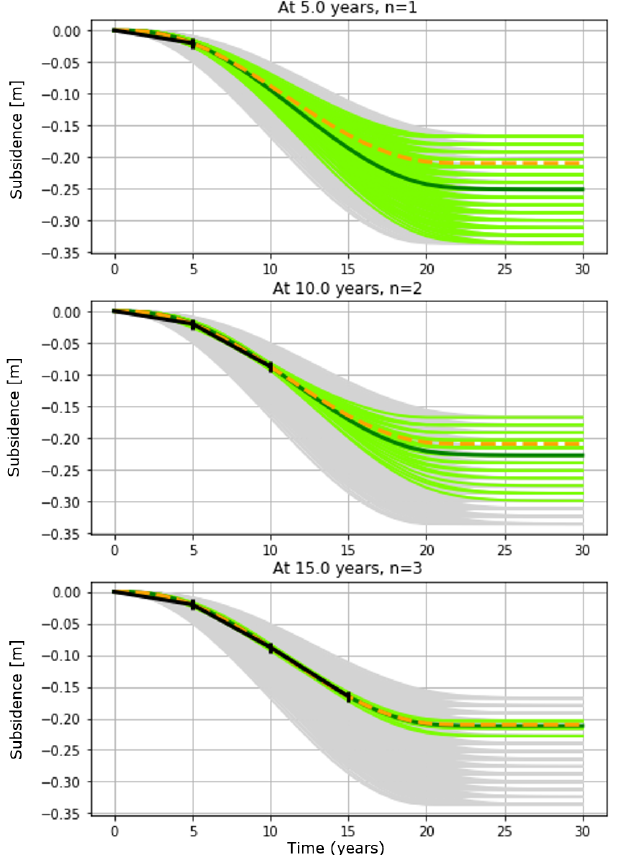
Figure 7. At five-year intervals, measurements in the deepest point of the subsidence bowl are used to constrain the initial ensemble (grey) to a 90% confidence band (green) and a new weighted esti- mate of the future subsidence (black